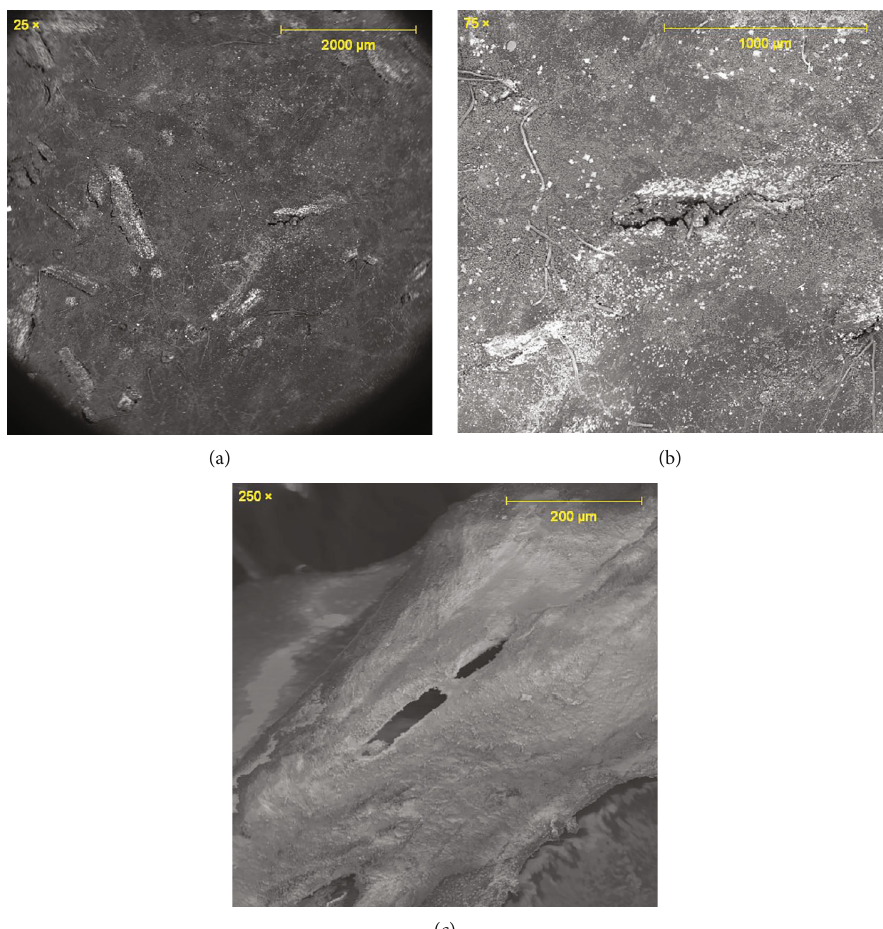
Figure 4: SEM images of OPEFB/acrylic thermoplastic composites after